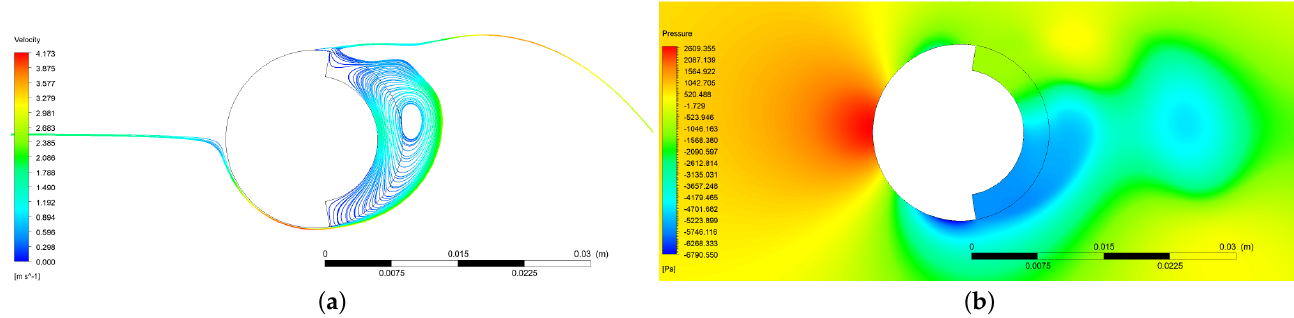
Figure 12. Flow recirculation in the β = 160 ◦ coating at Re = 4.2 × 10 4 , thickness t / D = 14.3% and a porosity of 20 PPI. ( a ) Velocity streamlines. ( b ) Pressure